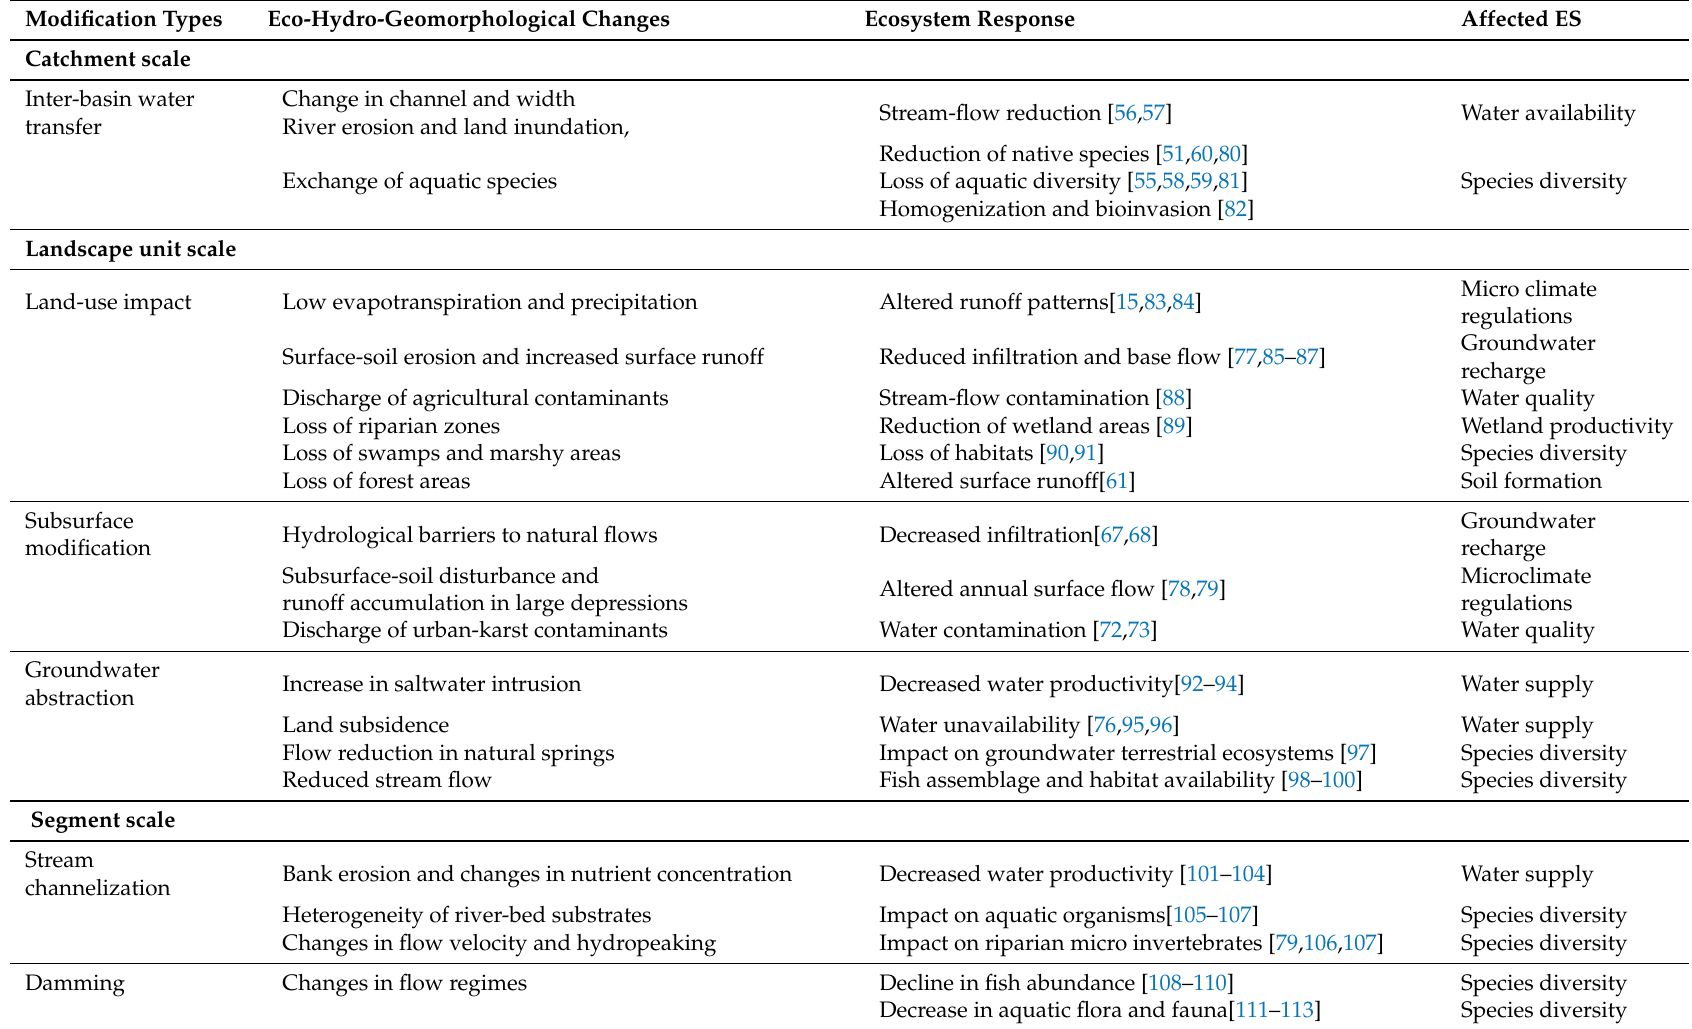
Table 4. Impact of anthropogenic modifications on ecosystem response concerning ecosystem services